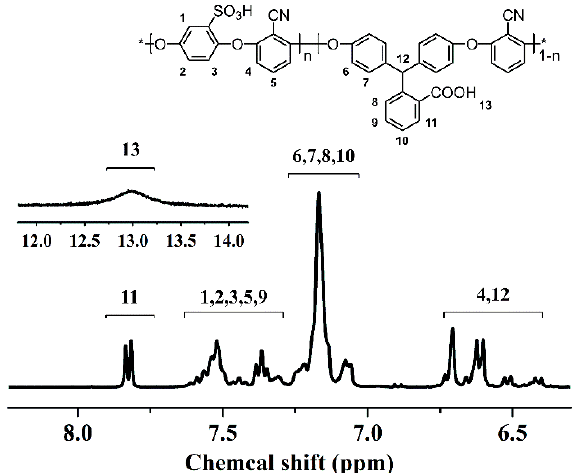
Polymers 2019 , 11 , x FOR PEER REVIEW Figure 2. 1 H NMR spectra of SCPEN copolymers. Figure 2. 1 H NMR spectra of SCPEN copolymers.